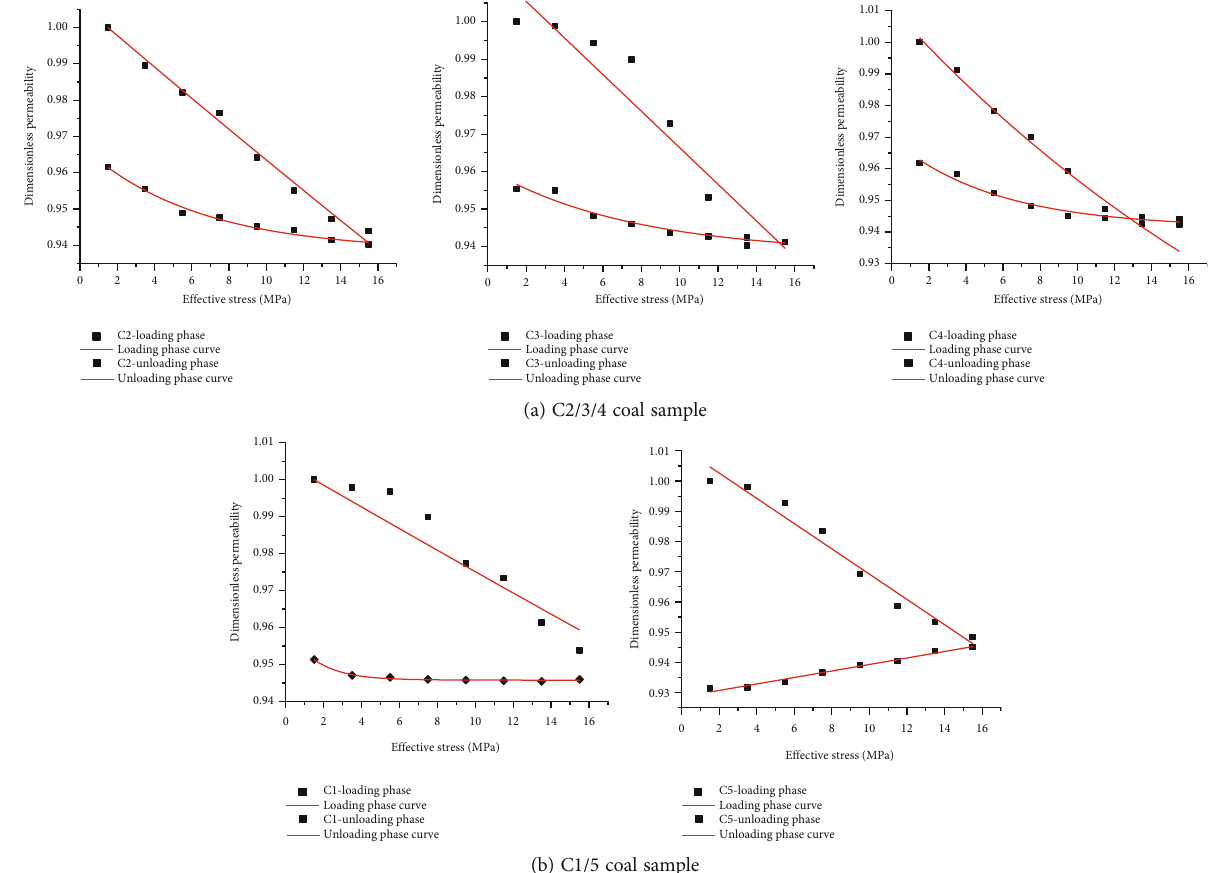
Figure 8: Permeability curve for the fi rst loading and unloading